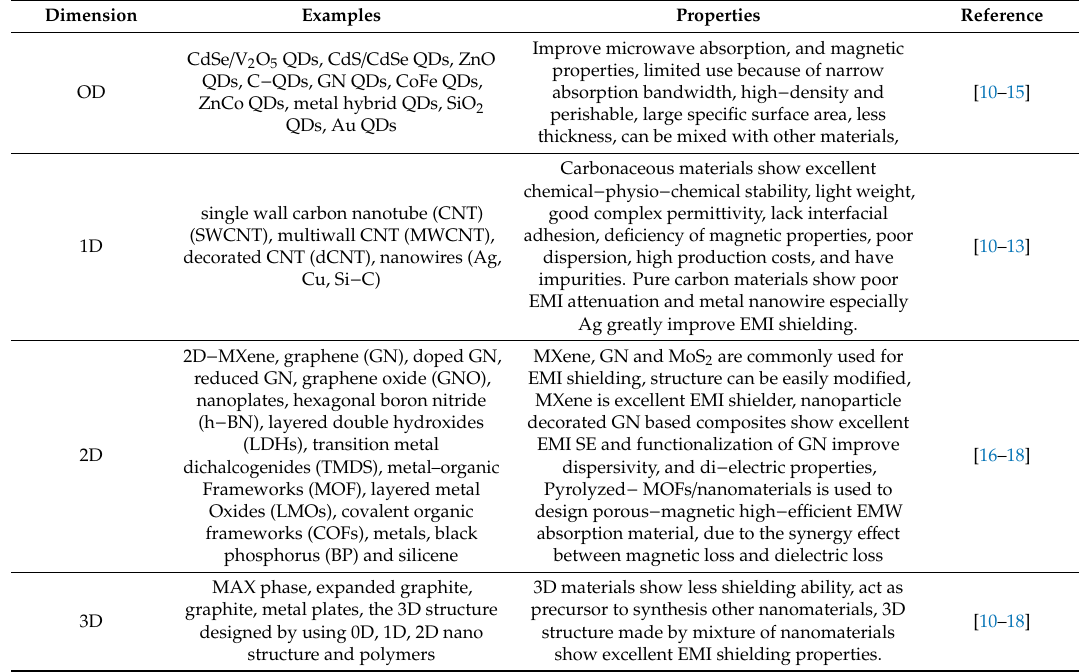
Table 1. Categorization of the nanomaterial with examples and